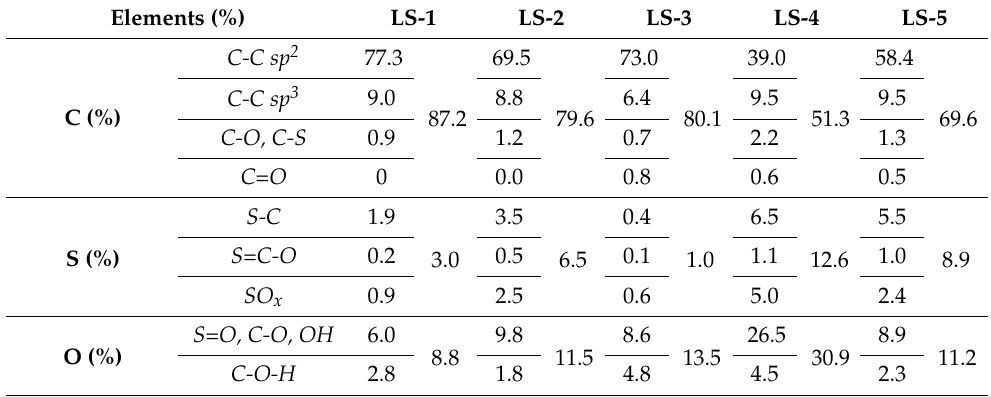
Table 3. XPS-based quantitative functionalities C, O, and S in LS-1 to -5.